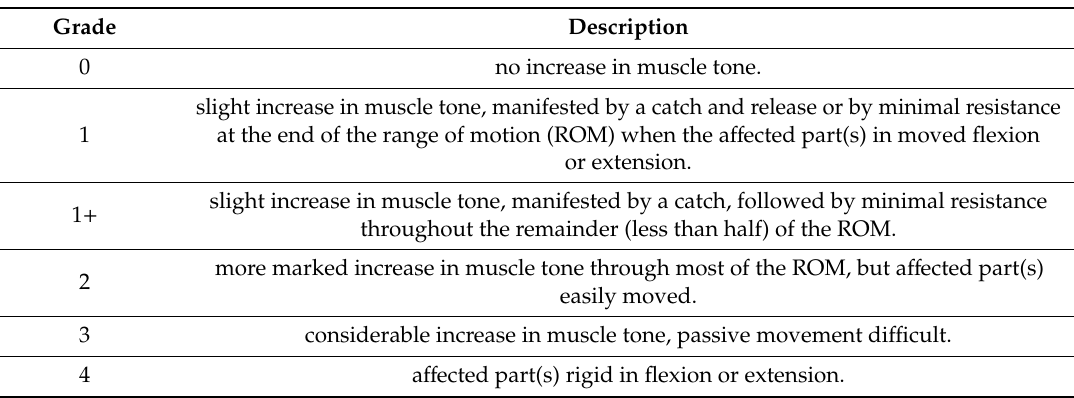
Table 1. Modified Ashworth Scale (MAS)